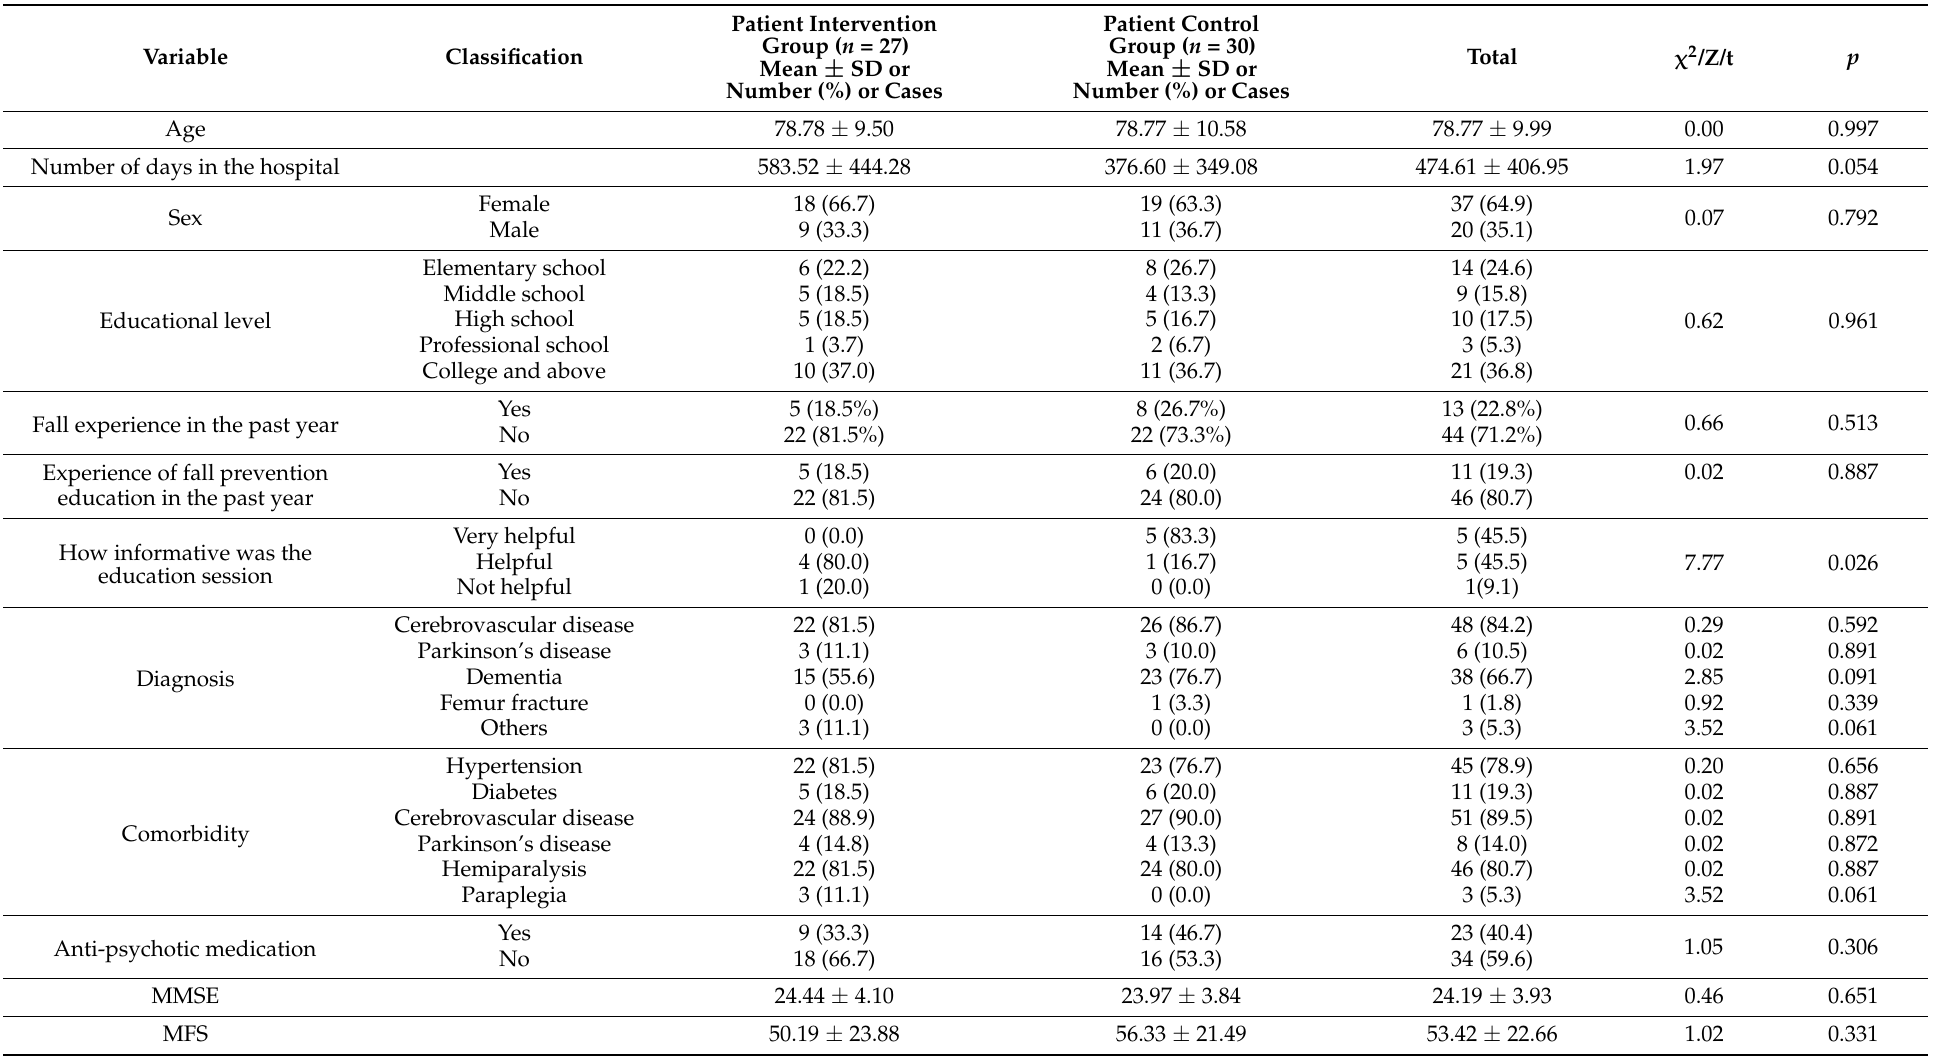
Table 2. Pre-test homogeneity test of general and disease-related characteristics between patients and nurses in the control and intervention